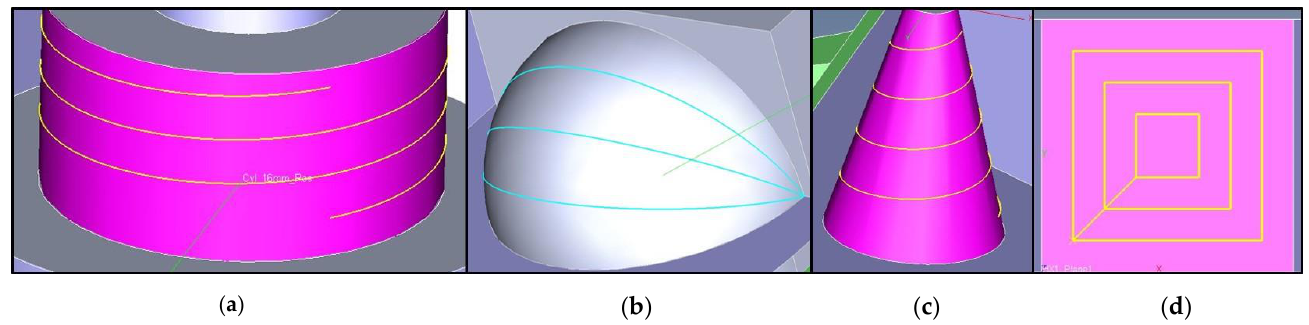
Figure 17. Illustrations of inspection paths for the different geometries. ( a ) Helical inspection path for cylinders; ( b ) three lateral paths for spheres; ( c ) a helical path for cones; ( d ) a single continuous path for planes.